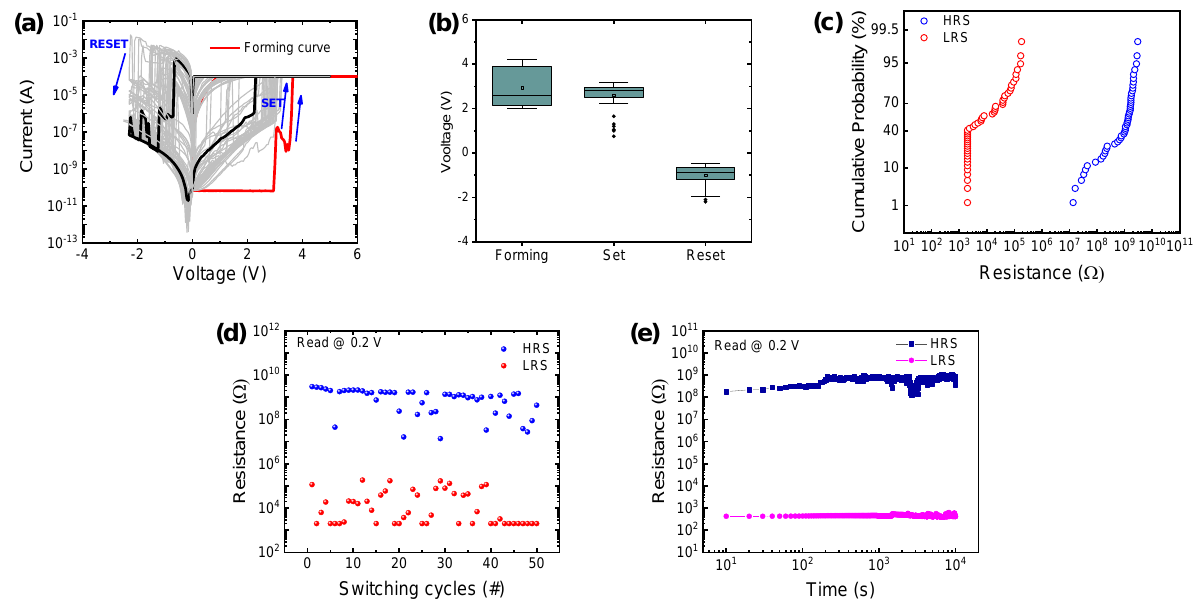
Figure 2. ( a ) I–V characteristics, ( b ) statistical distribution of forming voltage, set voltage, and reset voltage, ( c ) cumulative probability, ( d ) endurance cycle, and ( e ) retention of Cu/Al 2 O 3 /Si device.